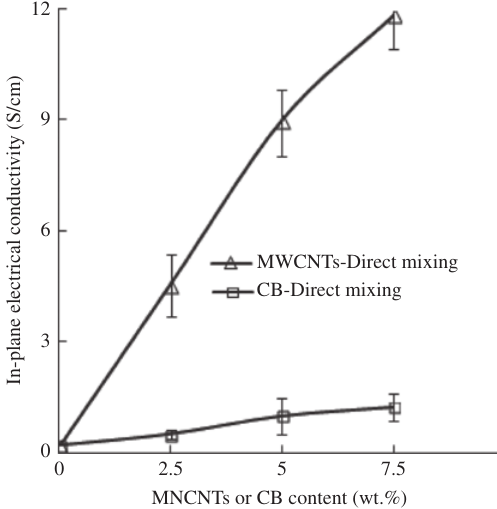
Figure 3: The effect of the MWCNTs and CB on the in-plane electrical conductivities of the PP/SG/xGnP composites.